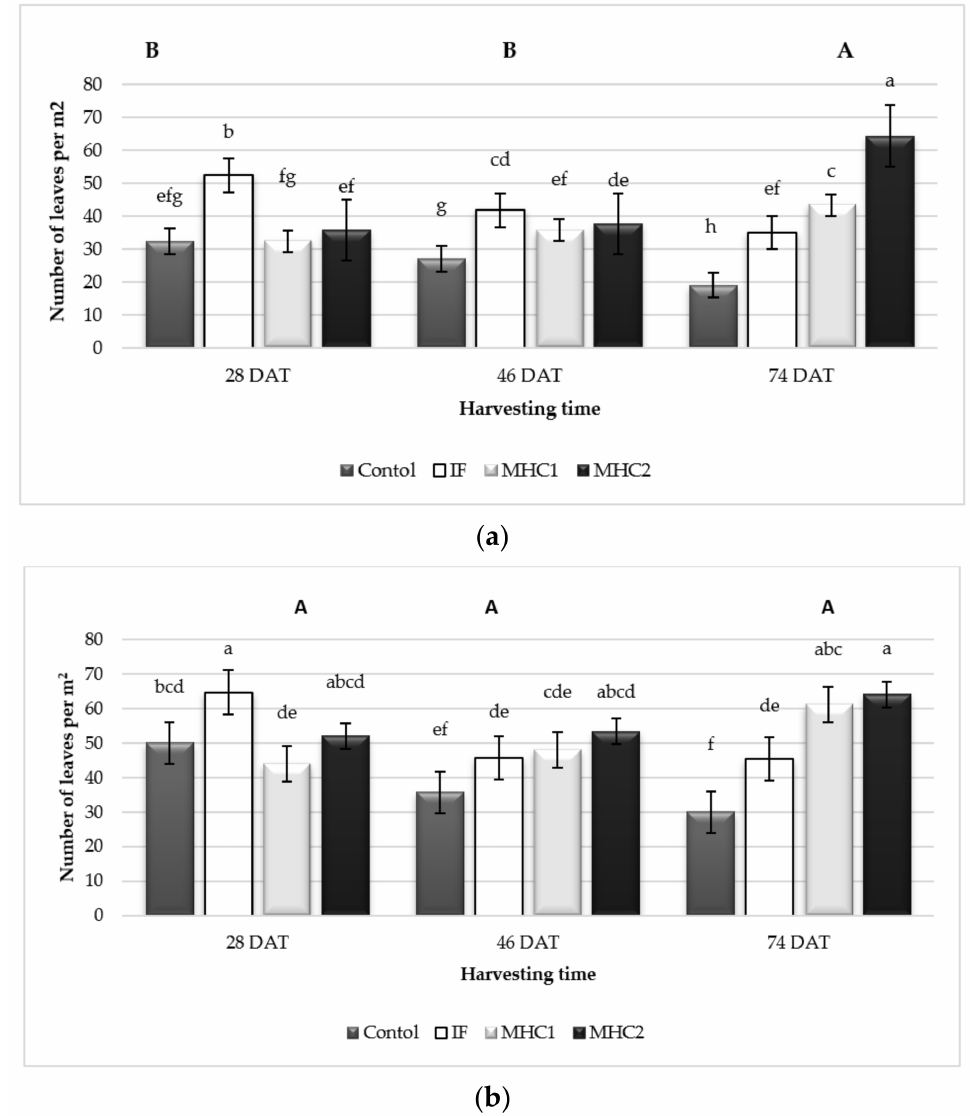
Figure 1. Effect of macadamia husk compost and inorganic fertilizer on number of leaves during three harvest period, 28 DAT = Harvest 1, 46 DAT = Harvest 2, Harvest 3 = 74 DAT, in 2018 ( a ) and 2019 ( b ). Different small letters indicate significant differences between fertilizer levels and harvest time ( p < 0.01 & p < 0.05 in 2018 & 2019, respectively), and different capital letters indicate significant differences between harvest time ( p <